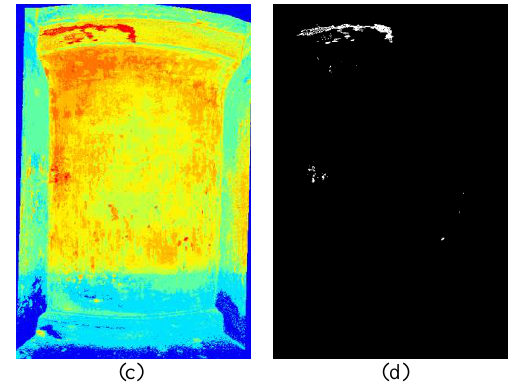
Figure 11. Classification results of wall 1 (8 clusters): (a) Original intensity; (b) damage areas detected using original intensity; (c) corrected intensity; (d) damage areas detected using corrected intensity